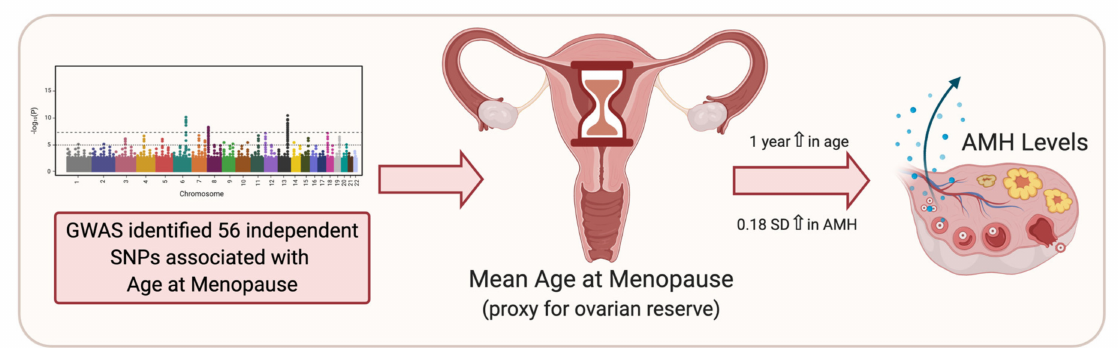
Figure 3. The application of Mendelian Randomisation to evaluate use of anti-Müllerian hormone (AMH) as a biomarker for ovarian reserve. Genome-wide association studies (GWAS) have identified 56 genetic variants associated with menopause timing [31]. Mendelian Randomisation was used to assess association of menopause timing (a proxy for ovarian reserve) with AMH concentrations [41] making use of the 56 genetic variants associated with age at natural menopause (ANM) to genetically predicted age at menopause. Earlier predicted ANM was associated with higher AMH concentrations supporting the use of AMH to measure ovarian reserve